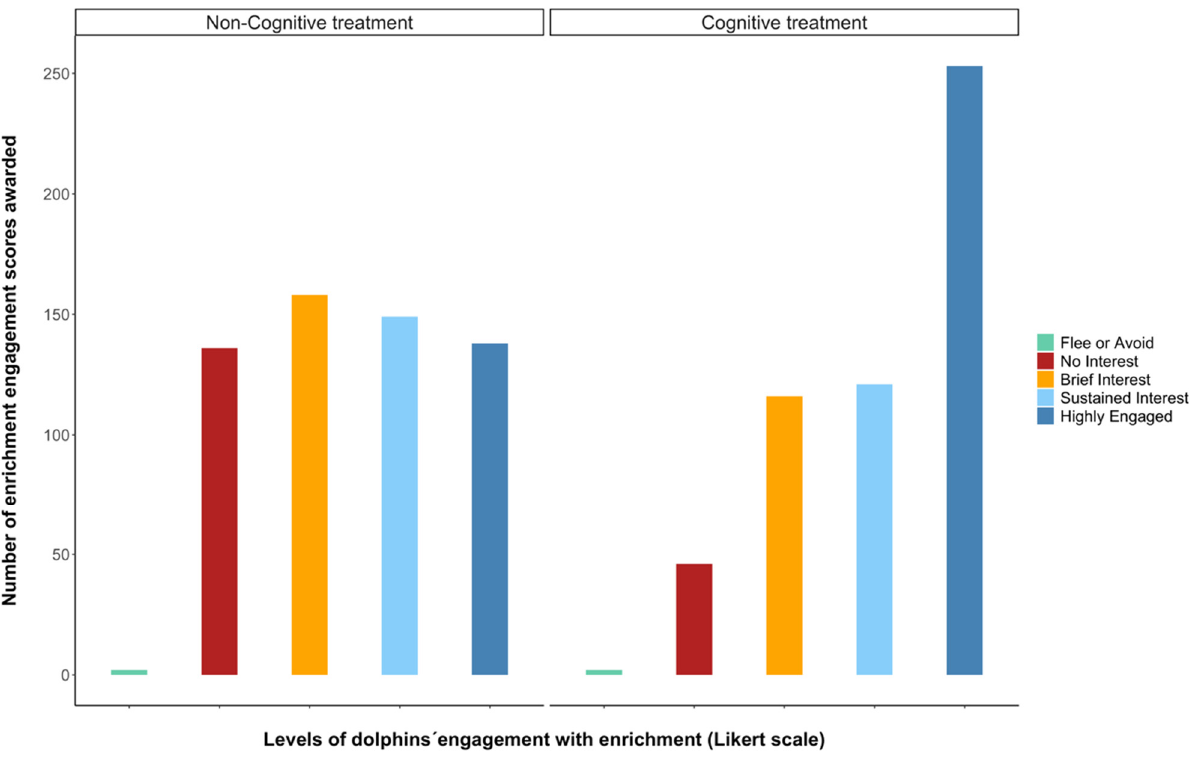
Figure 4. Dolphins´ enrichment engagement scores as scored by their caretakers. Coloured bars represent the number of times an enrichment engagement score (on a 1–5 Likert scale, Figure 2) was attributed to dolphins over the 8-week experiment. Table 4. Effects of treatments (non-cognitive vs. cognitive), week (week number of experiment), pool access (only show pool vs. both pools), age, general construction noise (presence vs. absence), drilling noise (presence vs. absence), type of session, duration of caretaker observations and time of day on enrichment engagement scores and WtP scores. Analyses by cumulative link mixed-effects models for ordinal data. Dolphin identity (a, b) and trainer identity (a) were included as random factors. Significant differences ( p < 0.05) and variables are highlighted in